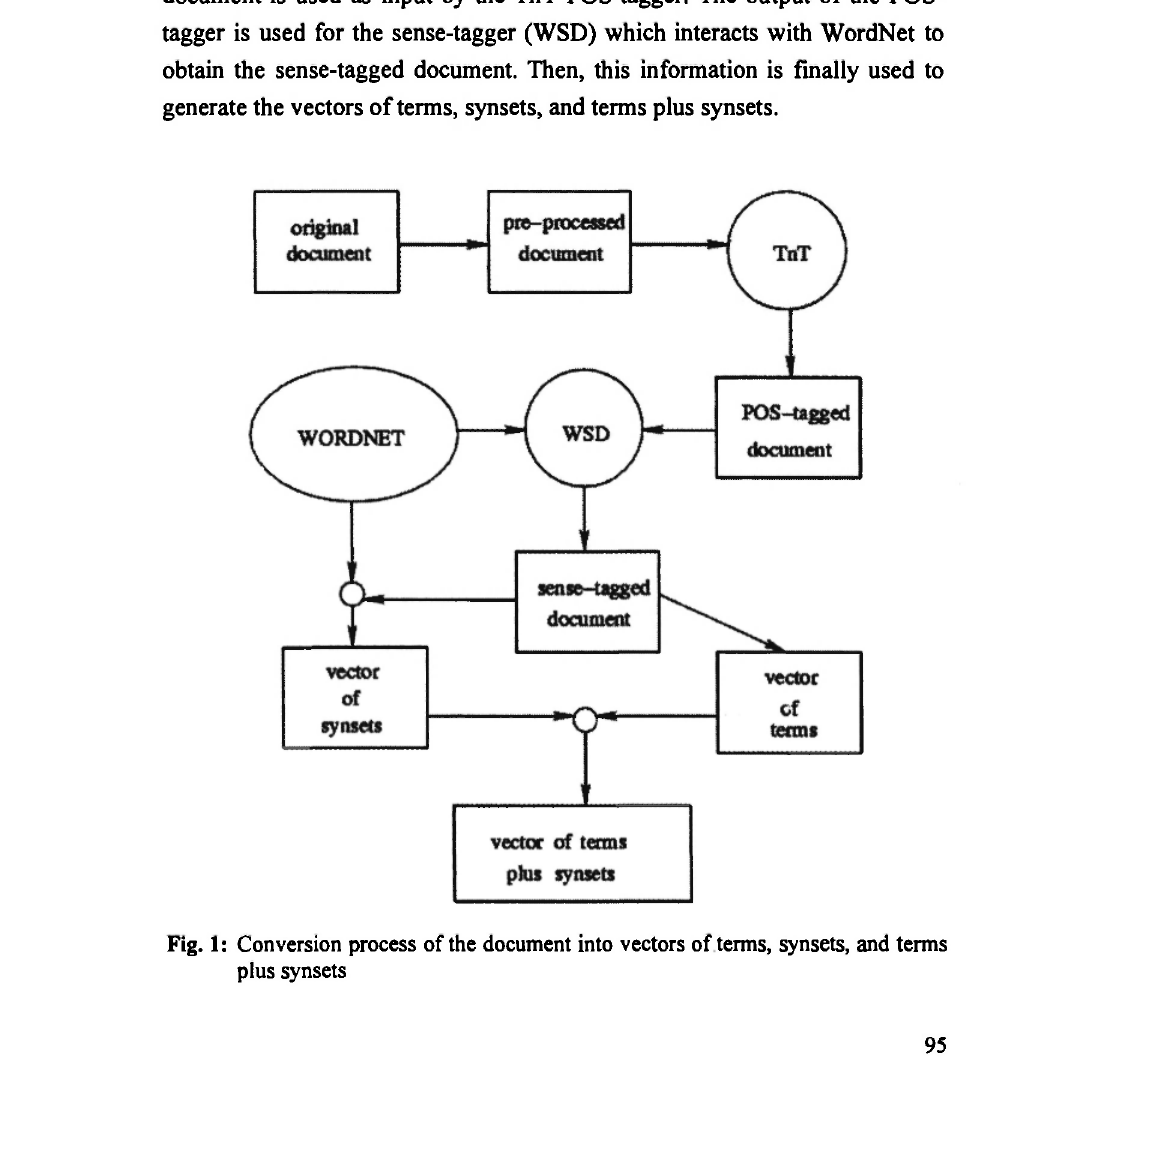
Fig. 1: Conversion process of the document into vectors of terms, synsets, and terms plus synsets